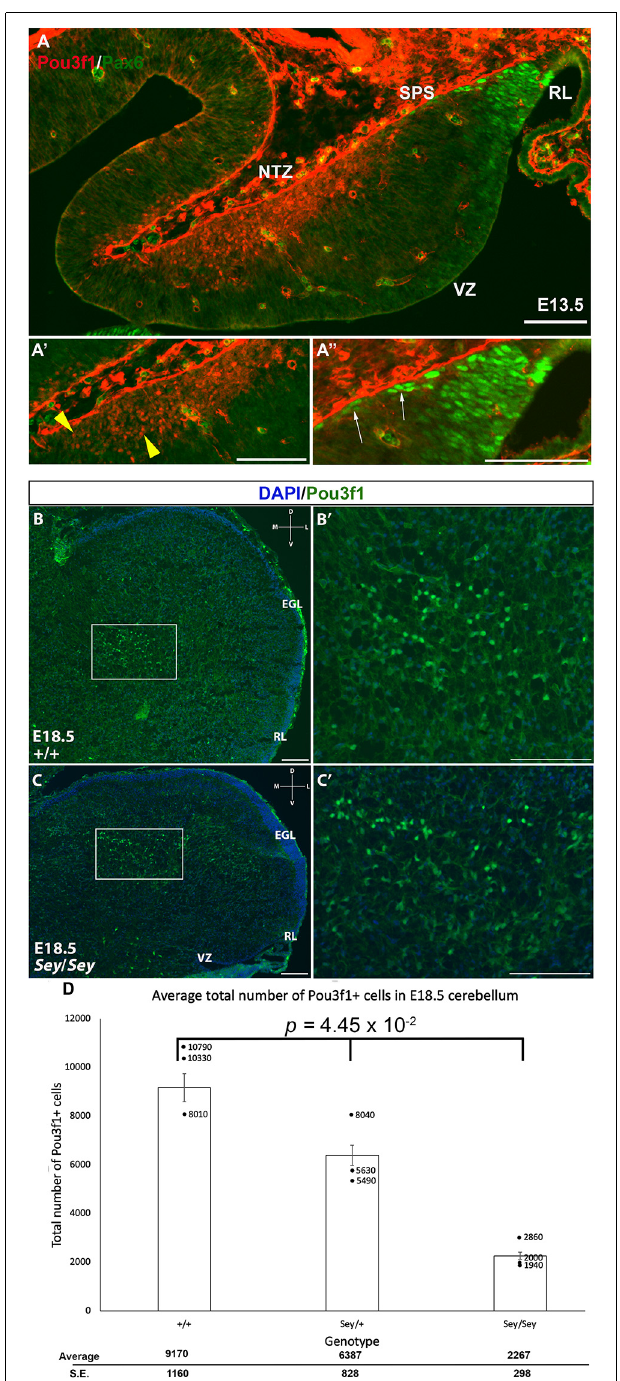
FIGURE 5 | The absence of co-localization between Pou3f1 and Pax6 in the wild-type cerebellum and the persistence of Pou3f1 expression in the Small Eye ( Sey ) mutant cerebellum. (A) In the E13.5 cerebellum (sagittal view), lack of co-localization between Pou3f1 and Pax6 is evident, with Pou3f1-labeled cells predominantly in the nuclear transitory zone (NTZ; A’ , yellow arrowheads), whereas Pax6-labeled cells are predominantly in the rhombic lip (RL) and the subpial stream (SPS; A” , white arrows). (B,B’) In the E18.5 wild-type cerebellum (coronal view), Pou3f1-expressing cells are found